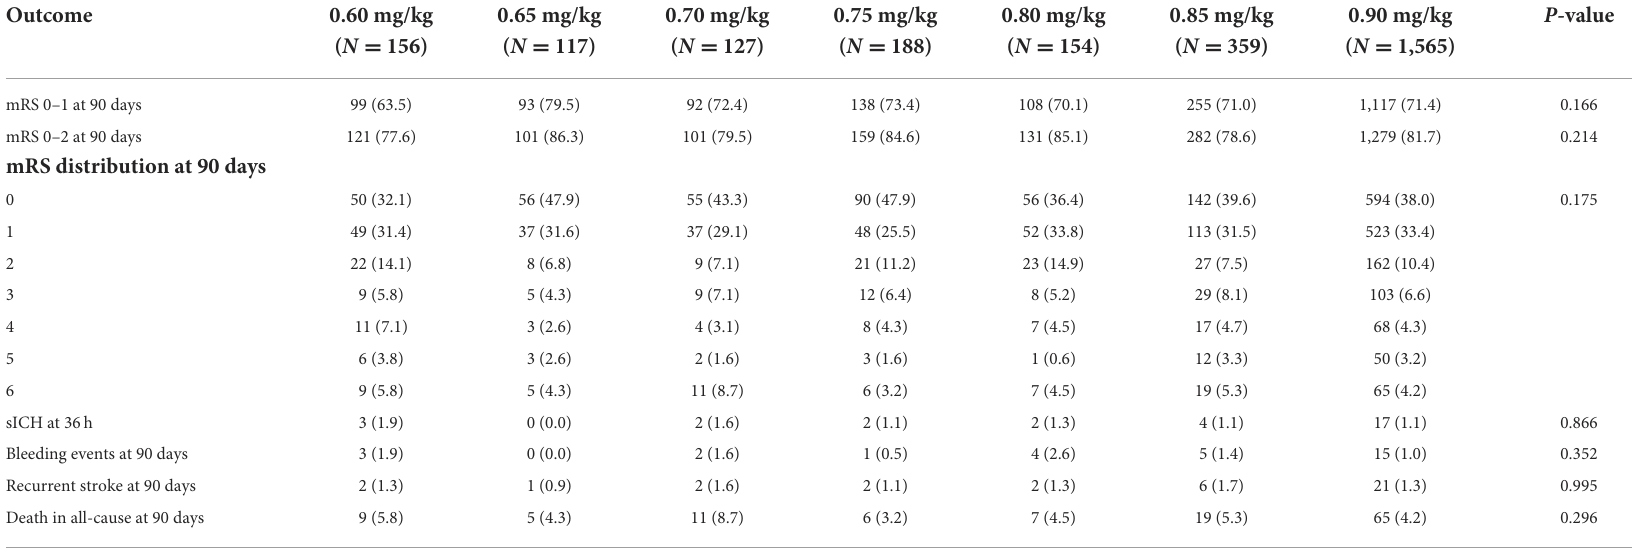
TABLE 2 Effectiveness and safety outcomes in multi-dose r-tPA groups.